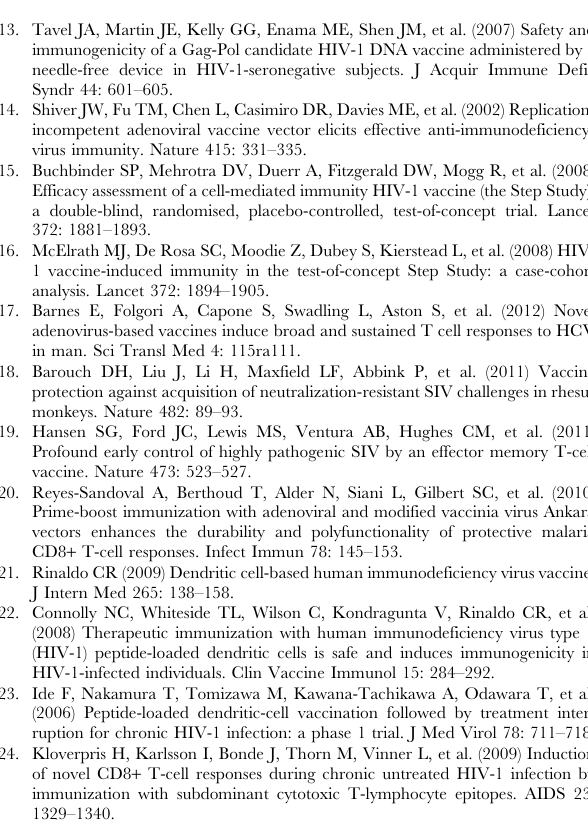
each individual. Figure S5 FACS plots showing CD4 + T-cell gating strategy (top panel) with effecter producing CD4 + T-cells shown after no stimulation, OPAL-HIV-Gag(c) or SEB stimulation at week 13 for subject 005 (A) and in (B) All six subjects from each dose group (0 mg, 12 mg and 24 mg) were tested for CMV specific responses by ICS shown as IFN c + /MIP1 b + double positive CD4 + T-cells processed from frozen PBMCs derived at week 0, 13 and 14 after first vaccination expressed as the mean of triplicate stimulations and shown for each